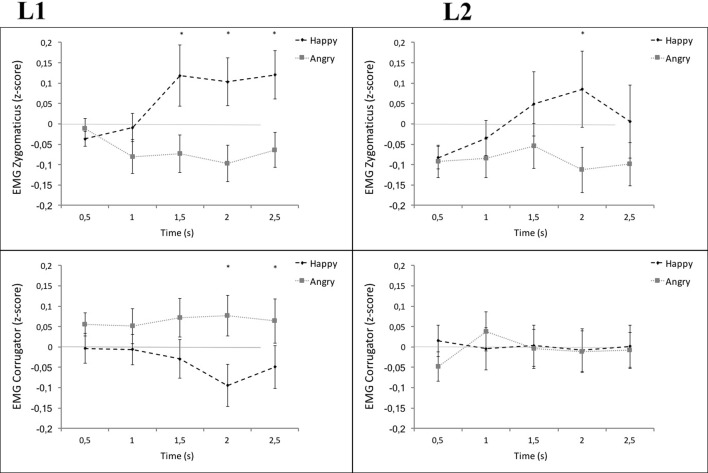
Mean zygomaticus (Upper) and corrugator activity (Lower) by time as a function of word-type and language. Figures show electromyography (EMG) activity in response to happy words (black) vs. angry words (gray) in L1 (left panel) and in L2 (right panel). Error bars represent ±1 SEM. ∗p ≤ 0.05 (two-tailed).